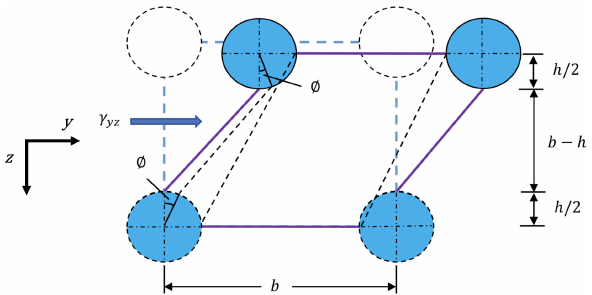
Figure 4: Distortion of the unit cell generated by strain in yz plane ( 𝛾 yz ); b is the distance between the adjacent fibers and h is the diameter of the fiber